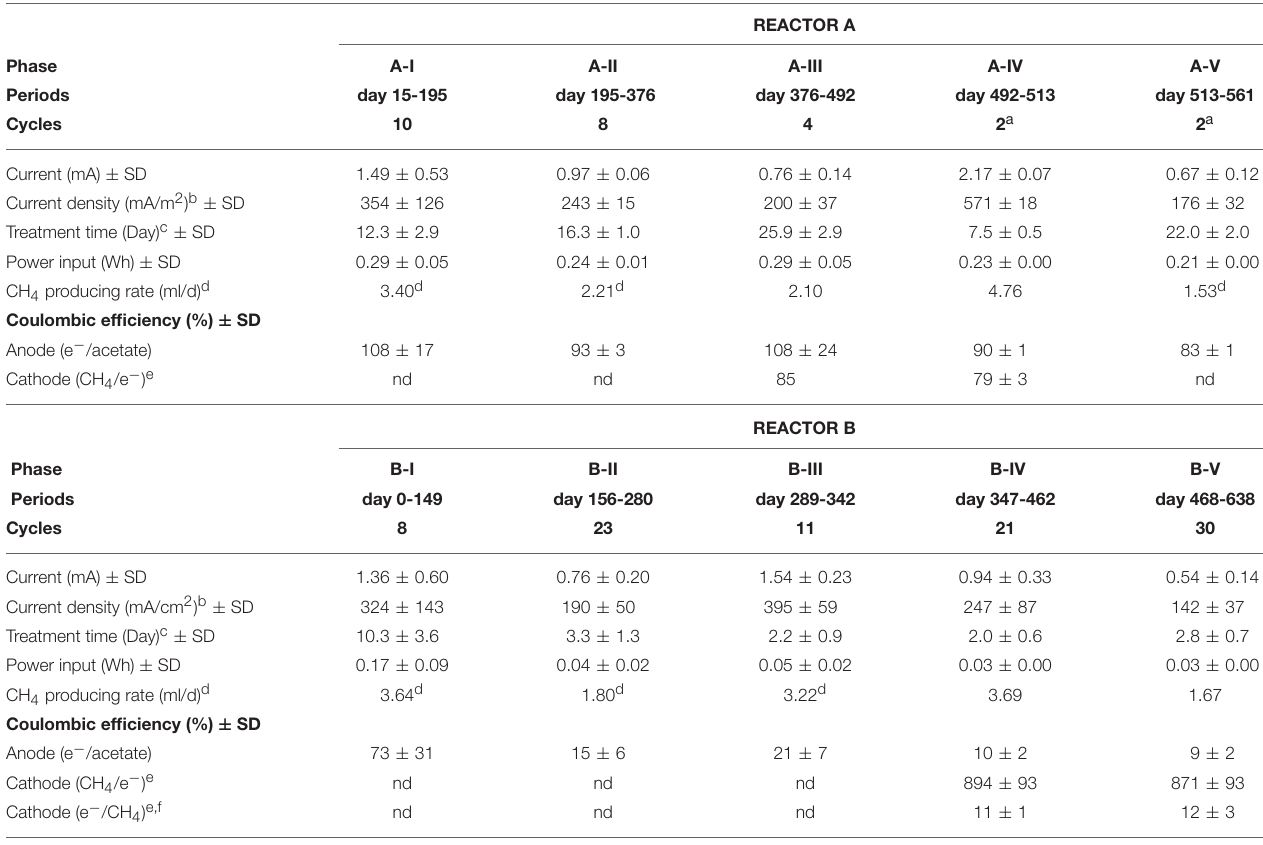
TABLE 1 | Summary of electromethanogenic profiles of BESs with 600mV voltage